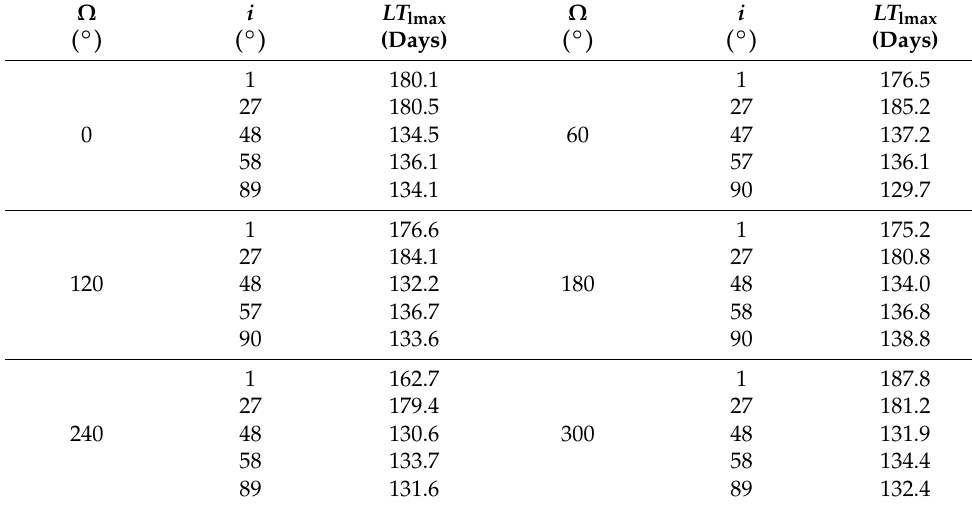
Table 3. The summarizing of the local maximum values of lifetime maintenance time.